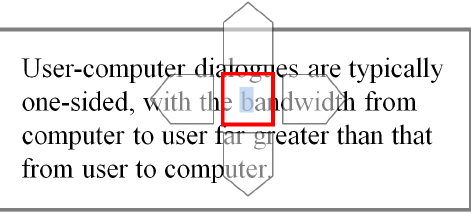
Fig. 7. The interface for adjusting the position of the cursor